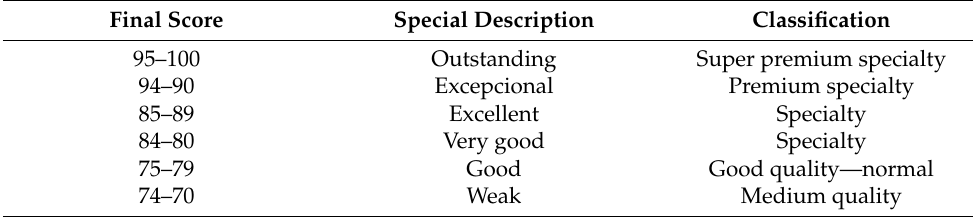
Table 5. Coffee beverage classification according to the cup quality. Final Score Special Description Classification 95–100 Outstanding Super premium specialty Excellent Specialty Very good Specialty 75–79 Good Good quality—normal 74–70 Weak Medium